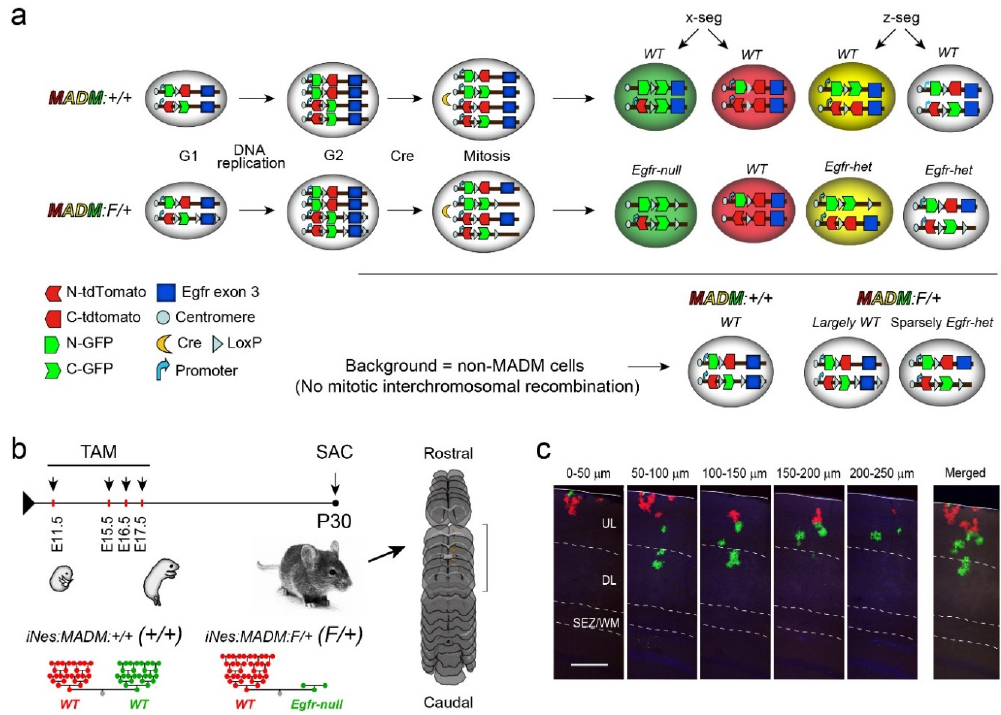
Figure 1. Clonal Analysis of Gliogenesis using Mosaic Analysis with Double Markers (MADM). ( a ) Molecular basis of labeling individual progenitor clones with distinct fluorescent reporters (GFP, green and tdTomato, red). Cre mediated interchromosomal mitotic recombination is followed by two distinct segregation patterns (x-seg and z-seg) generating clonal siblings in distinct colors as indicated. In control MADM mice, all cells will be WT and referred to as +/+. When a single floxed allele for Egfr is introduced, green cells lack Egfr ( Egfr-null ), while the red cells are maintained as WT (F/+ mice). Background genotypes obtained from the described genetic combinations using a tamoxifen induced Nestin-creERT2 transgene result in substantial differences in the Egfr genotype in background cells (non-MADM recombination events) which exert non-autonomous effects on MADM cells. ( b ) Schematic of tamoxifen (TAM) induction time points during embryonic development, and processing